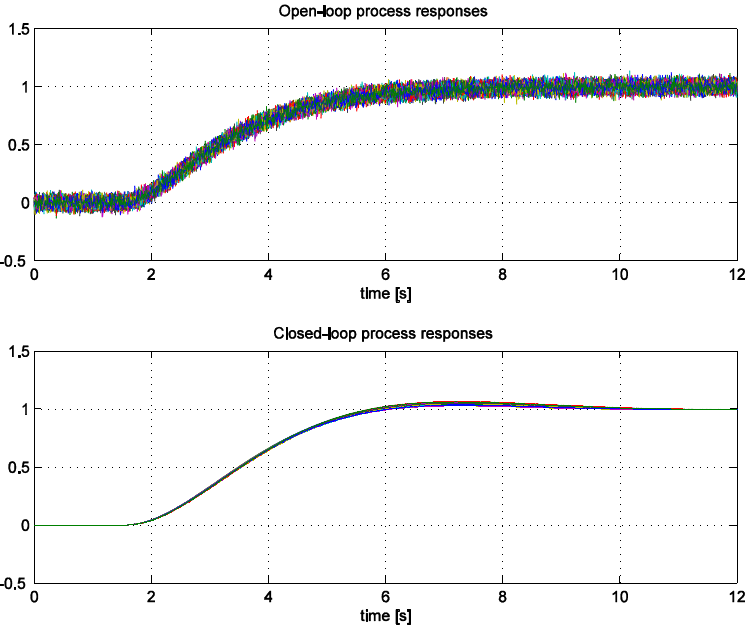
Figure 9. One hundred process open-loop responses with measurement noise ( top figure ) and closed-loop responses ( bottom figure ) using the WLS tuning method without additional noise (for clarity).